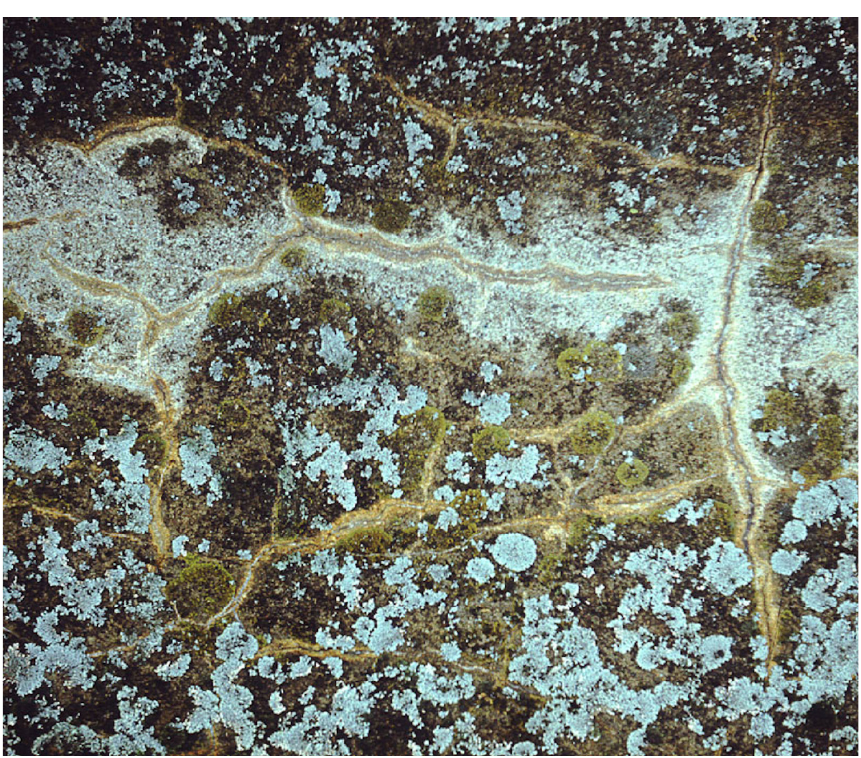
Figure 4. Lichens on a concrete wall (photograph taken during the filming of Andrei Tarkovsky’s Stalker ) © Serguei Bessmertny.